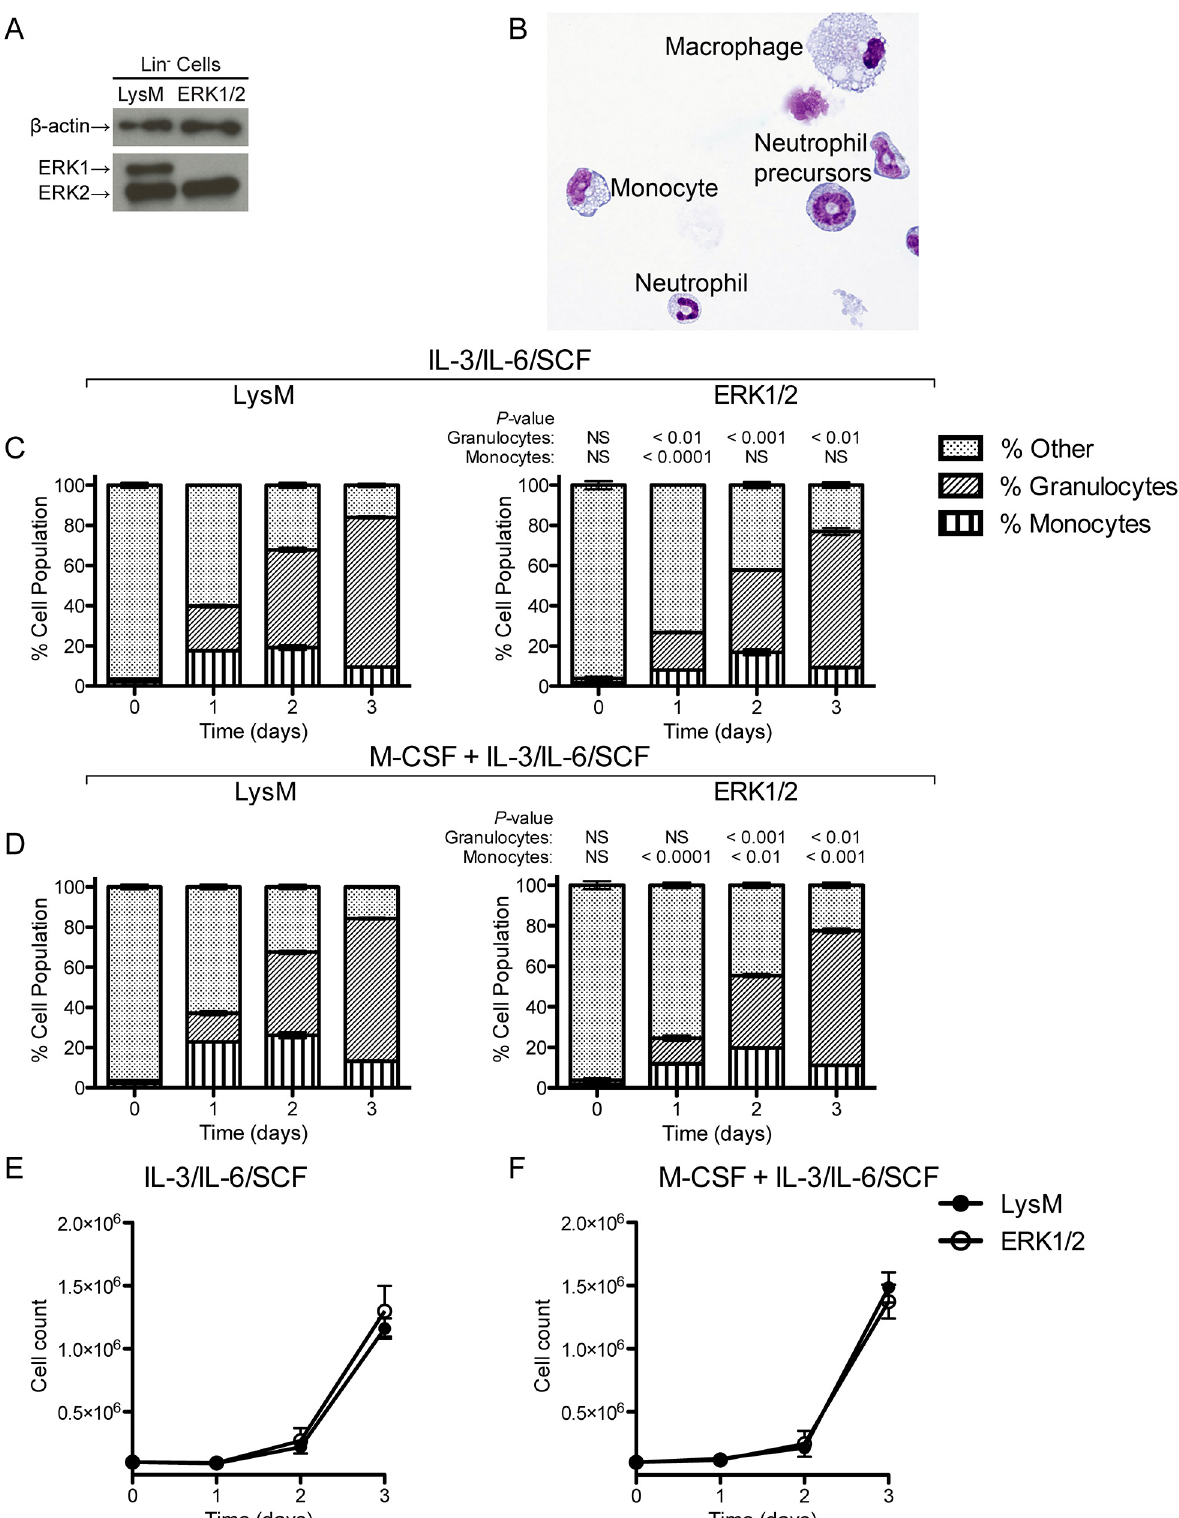
Fig 7. Production of monocytes and macrophages by in vitro culture of Lin - progenitors from ERK1/2 and LysM bone marrow. (A) Western blot of Lin - cells from LysM and ERK1/2 bone marrow. (B) Cytospin preparation showing representative cells generated by culture of Lin - cells for 4 d in 5 ng/ml IL –